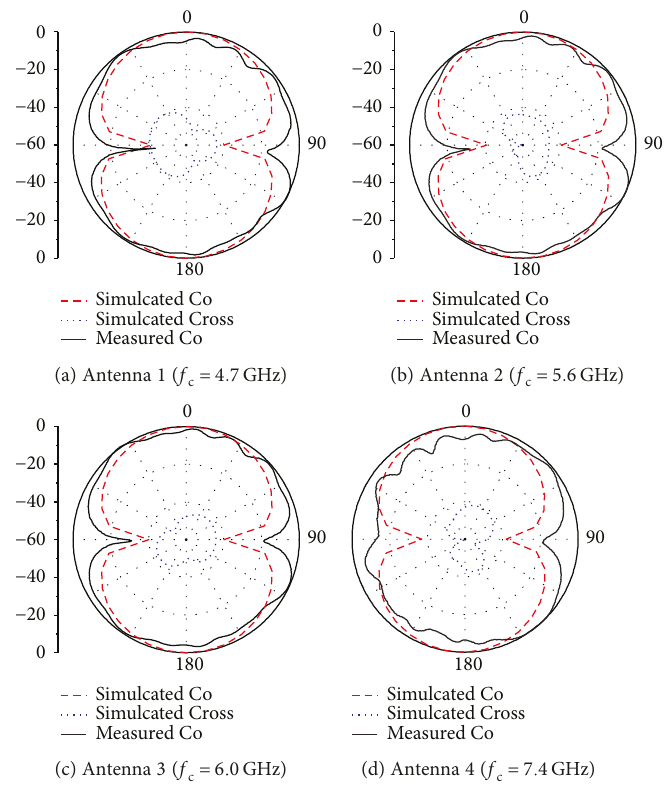
Figure 11: Simulated and measured radiation patterns in the E plane. ( x - y plane).